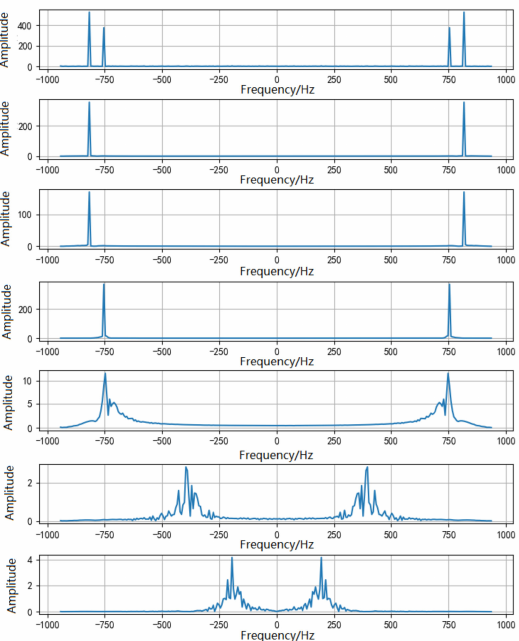
Figure 10. IMF Component Corresponding Spectrum of Fault 5.